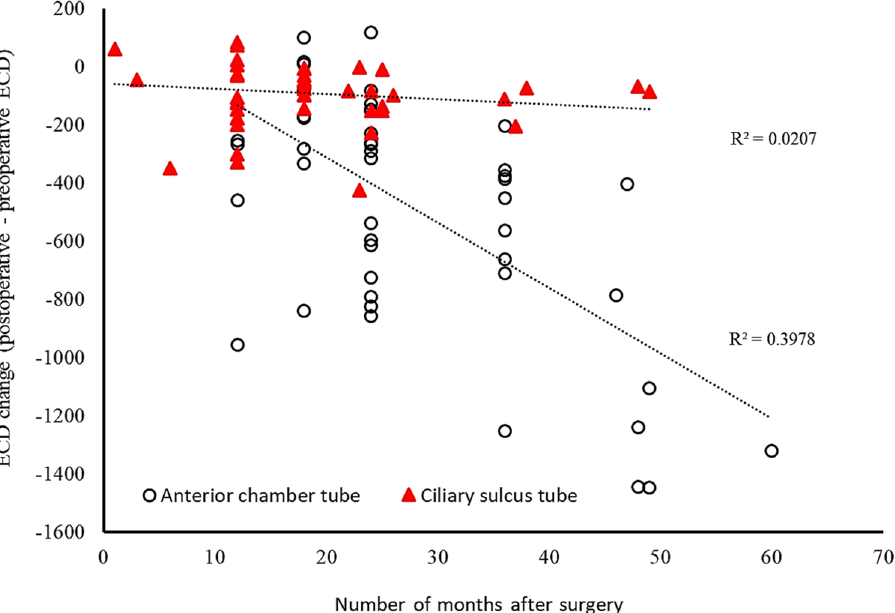
Figure 2. Scatterplots of ECD loss over time following Ahmed glaucoma valve implantation. The tubes were placed either in the anterior chamber (circle) or in the ciliary sulcus (red arrowhead).The horizontal axis shows the time elapsed from the time of surgery to the repeat ECD measurement in months. The vertical axis shows ECD change between preoperative and postoperative measurements. The goodness of the fit to the regression line is shown as r 2 .